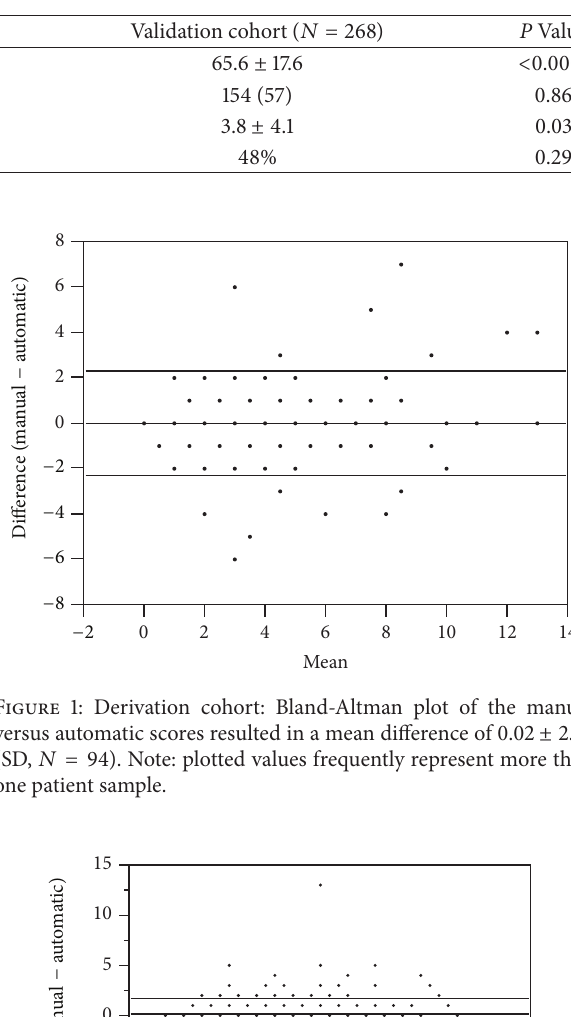
Table 1: Baseline characteristics of the derivation and validation cohorts.